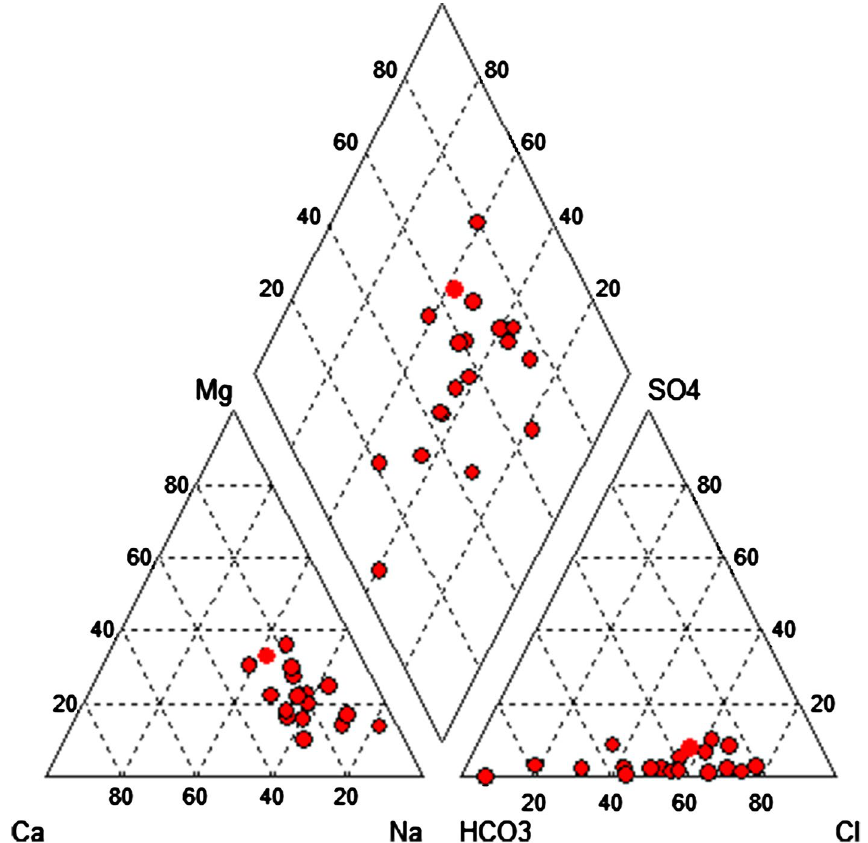
Fig. 4 Piper trilinear diagram of groundwater of the study